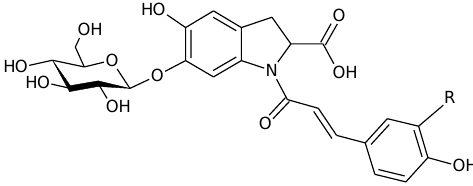
Figure 7. Molecular structures of oleracein W (R=OH) obtained as peak 1 and oleracein A (R=H) as peak 2 of the chromatogram of purslane.